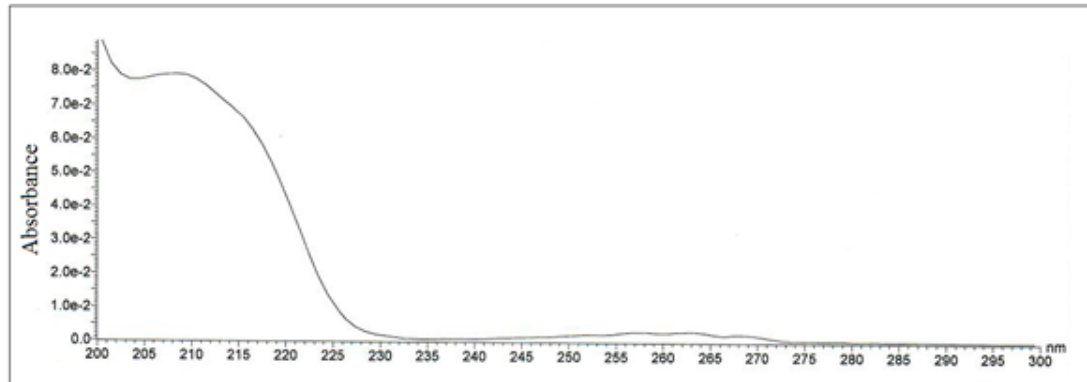
Figure 10. HPLC-diode array chromatogram of amygdalin solution (0.5 mg mL − 1 ).